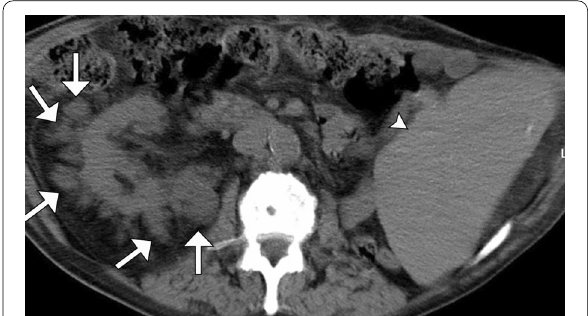
Fig. 12 Renal extramedullary hematopoiesis. Axial noncontrast CT in an anemic patient demonstrates splenomegaly (arrowhead) and multiple right renal masses (arrows). The constellation of findings is suspicious for underlying lymphoma. A biopsy of one of the renal masses shows hematopoietic tissue consistent with extramedullary hematopoiesis